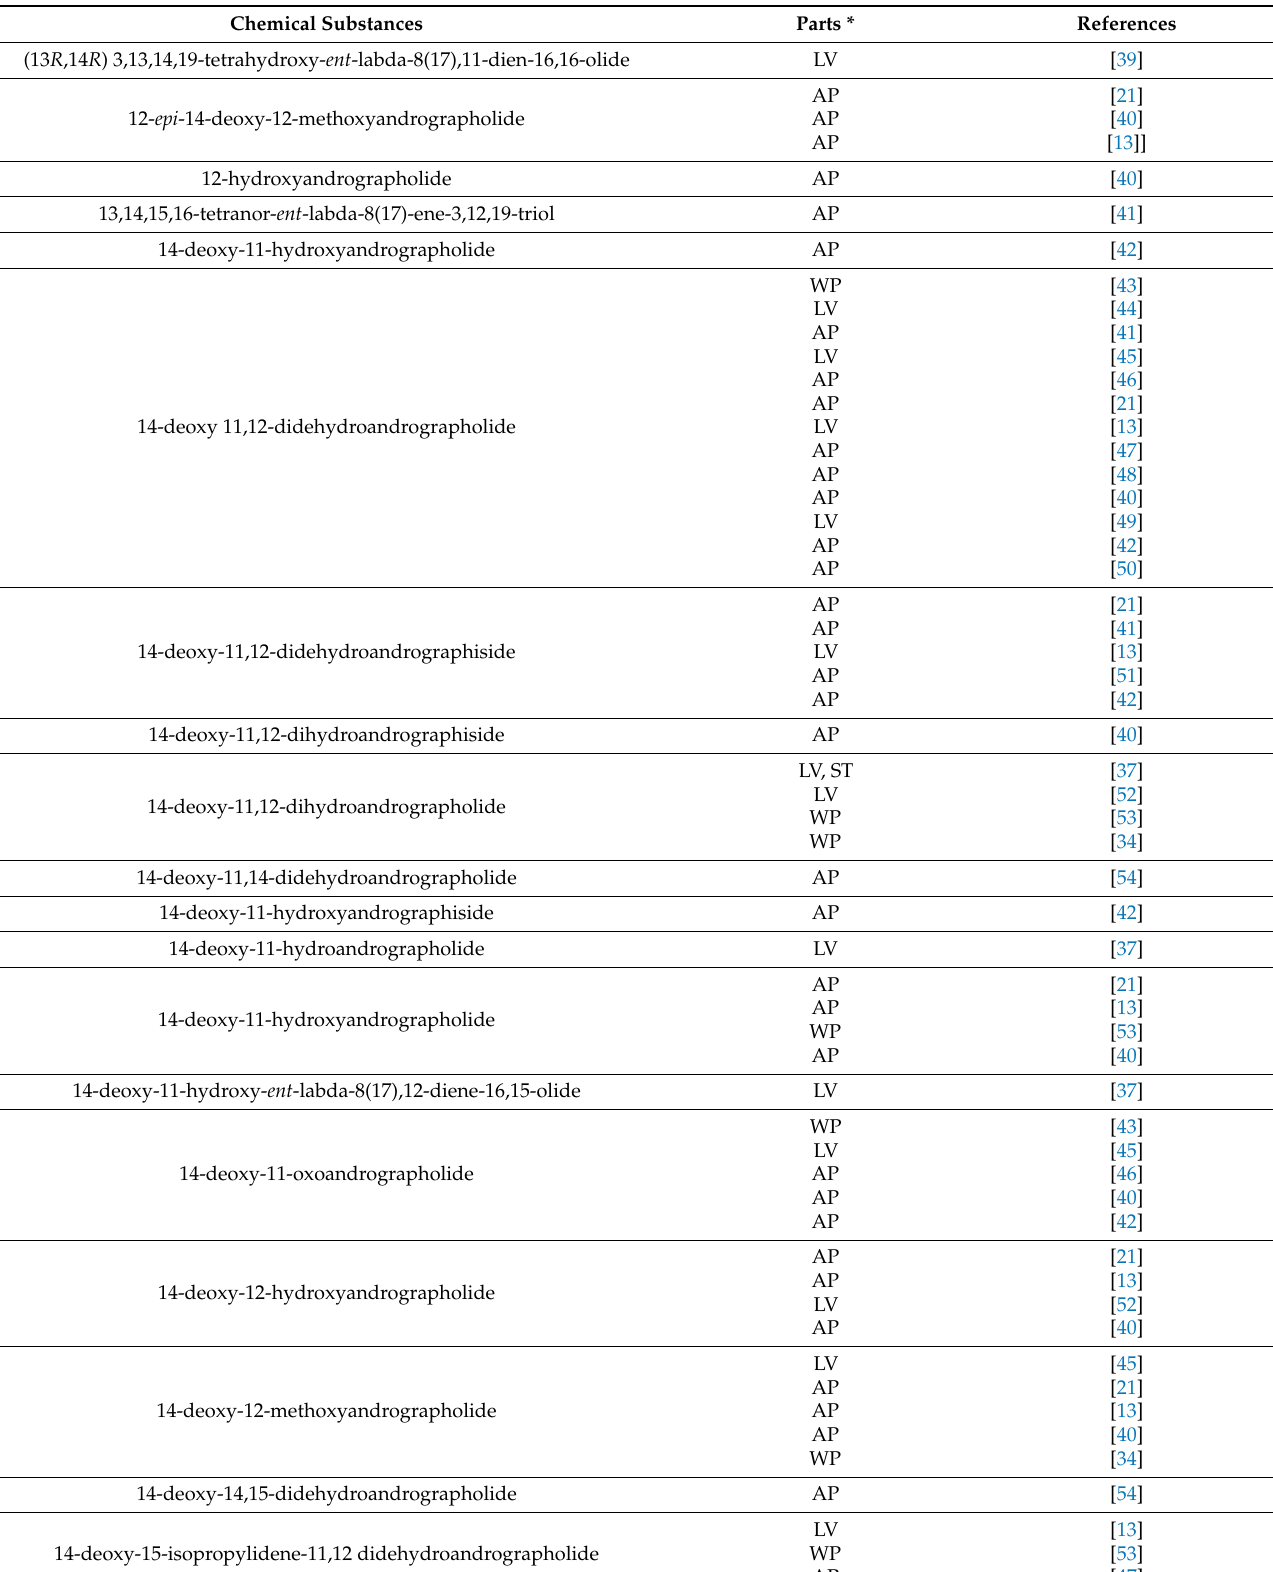
Table 1. Chemical constituents of Andrographis paniculata : ent -labdane diterpenoids, flavonoids, and other